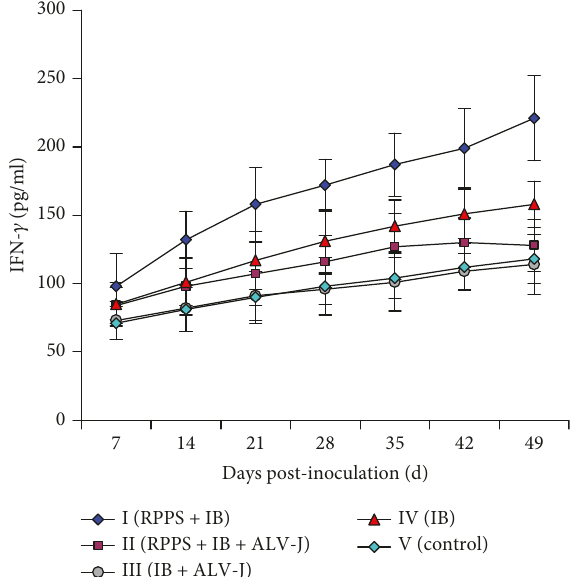
Figure 7: Changes of cytokine IFN- γ level in the